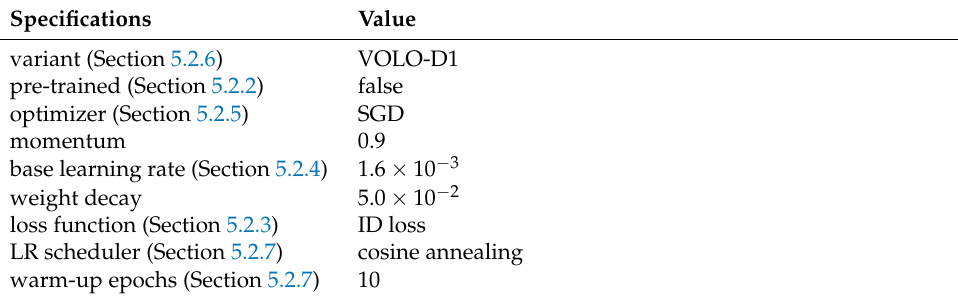
Table 6. Settings of the baseline model. ss. refers to the subsections where the hyperparameter is